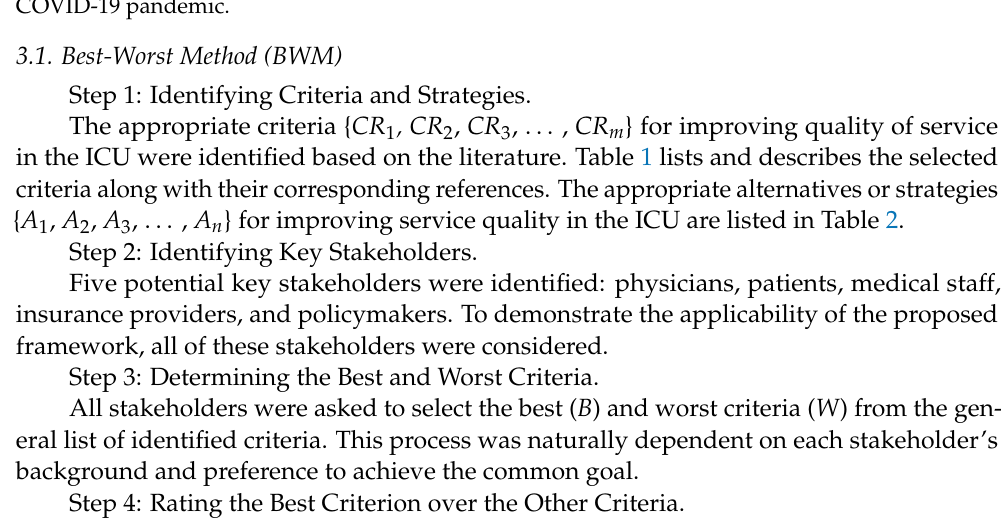
Figure 2. BWM–MAMCA–MOLP framework for improving service quality in an ICU during the COVID-19